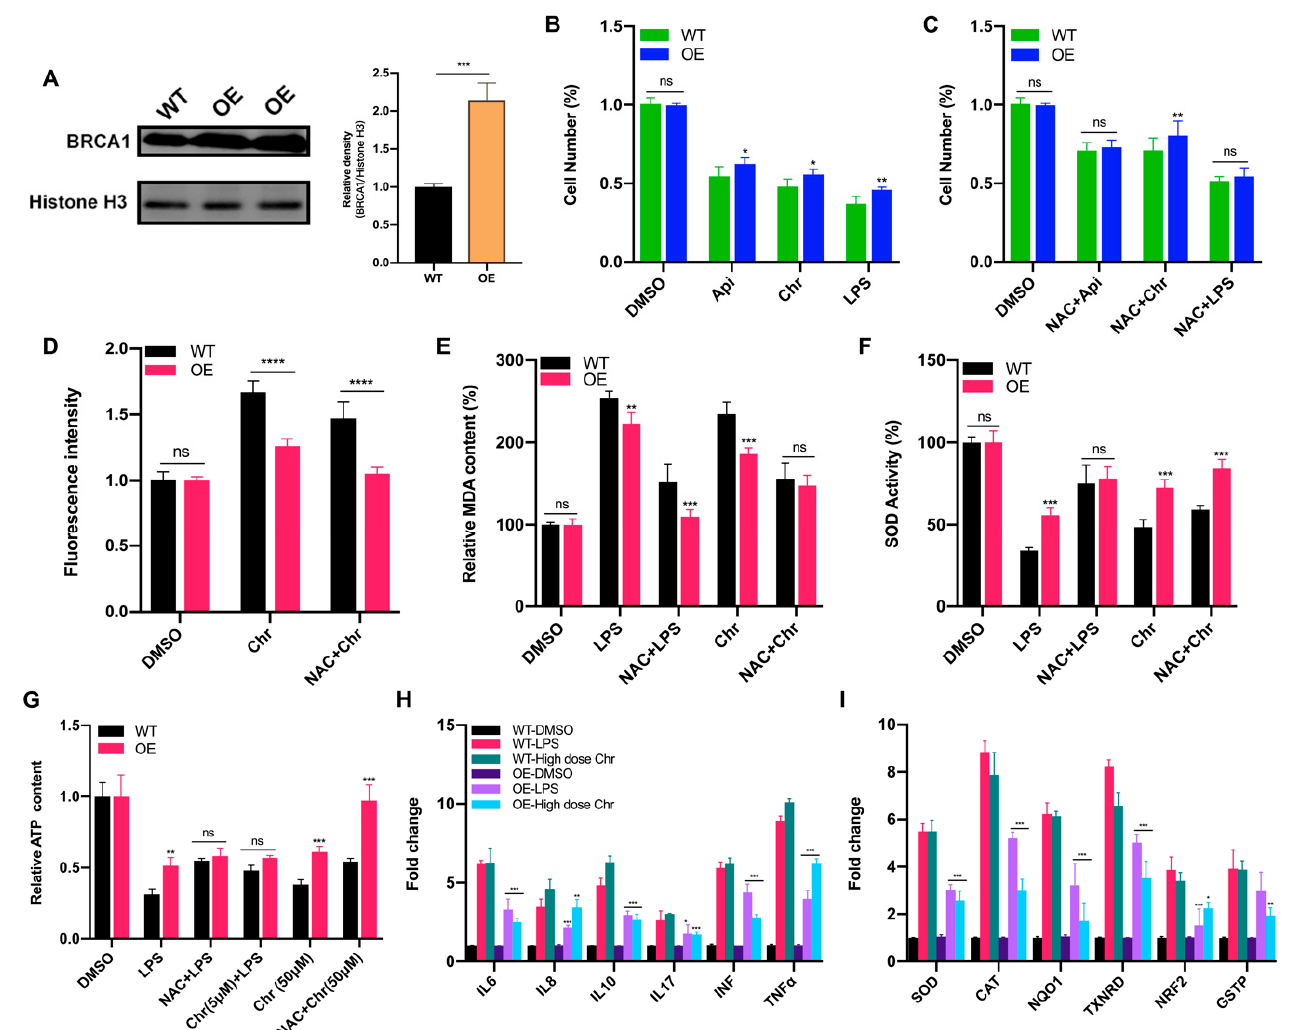
Figure 8. BRCA1 overexpression attenuated the oxidative stress induced by LPS or high dose of flavonoids. ( A ) The Western blot of wild type (WT) and BRCA1-overexpressing cells (OE). ( B ) The cell number of WT/OE cells treated with LPS or 50 µ M apigenin/chrysin for 48 h. ( C ) The cell number of WT/OE cells pretreated with 5 µ M NAC for 6 h and then 50 µ M apigenin/chrysin or 5 µ g/mL LPS for 48 h. ( D ) The fluorescence intensity of ROS detected by DCFH-DA assay. Chr: 50 µ M chrysin for 24 h. NAC + Chr: pretreated with 5 µ M NAC for 6 h and then 50 µ M chrysin for 18 h. ( E ) The MDA content of WT/OE cells. LPS: 5 µ g/mL LPS for 24 h. NAC + LPS: pretreated with 5 µ M NAC for 6 h and then LPS for 18 h. ( F ) The SOD activity of WT/OE cells. ( G ) The relative ATP content of different groups. ( H ) The qPCR results of inflammatory genes in WT/OE cells. LPS: 5 µ g/mL LPS for 24 h. High dose Chr: 50 µ M chrysin for 24 h. The marked significance of OE groups was obtained by comparing the WT groups with the same treatment, respectively. ( I ) The qPCR results of antioxidative genes in WT/OE cells. The marked significance of OE groups was obtained by comparing the WT groups with the same treatment, respectively. Data was shown as the mean ± SD. * p < 0.05, ** p < 0.01, *** p < 0.001, **** p < 0.0001. ns indicates no significant difference.